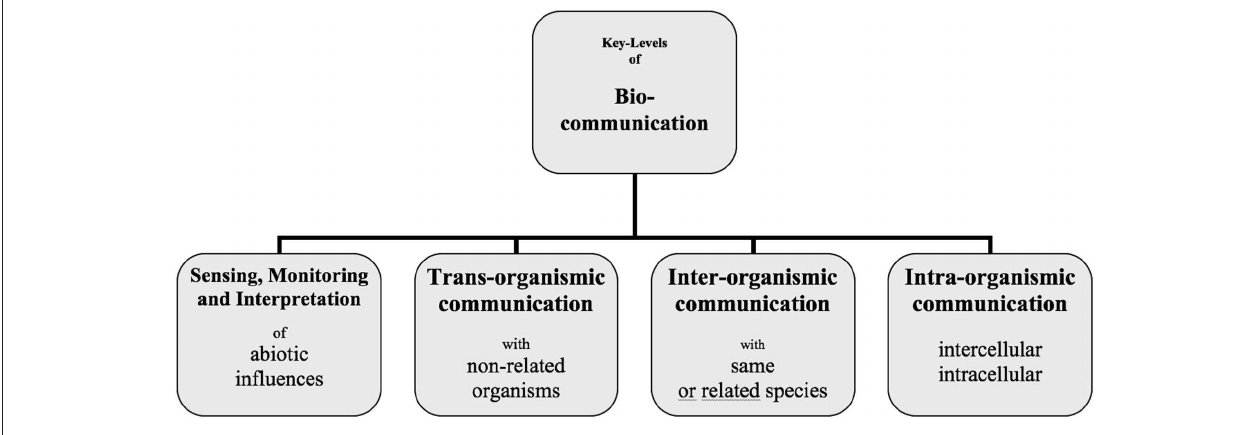
FIGURE 1 | The biocommunication approach identified four levels into which cellular organisms are involved since the start of their life until